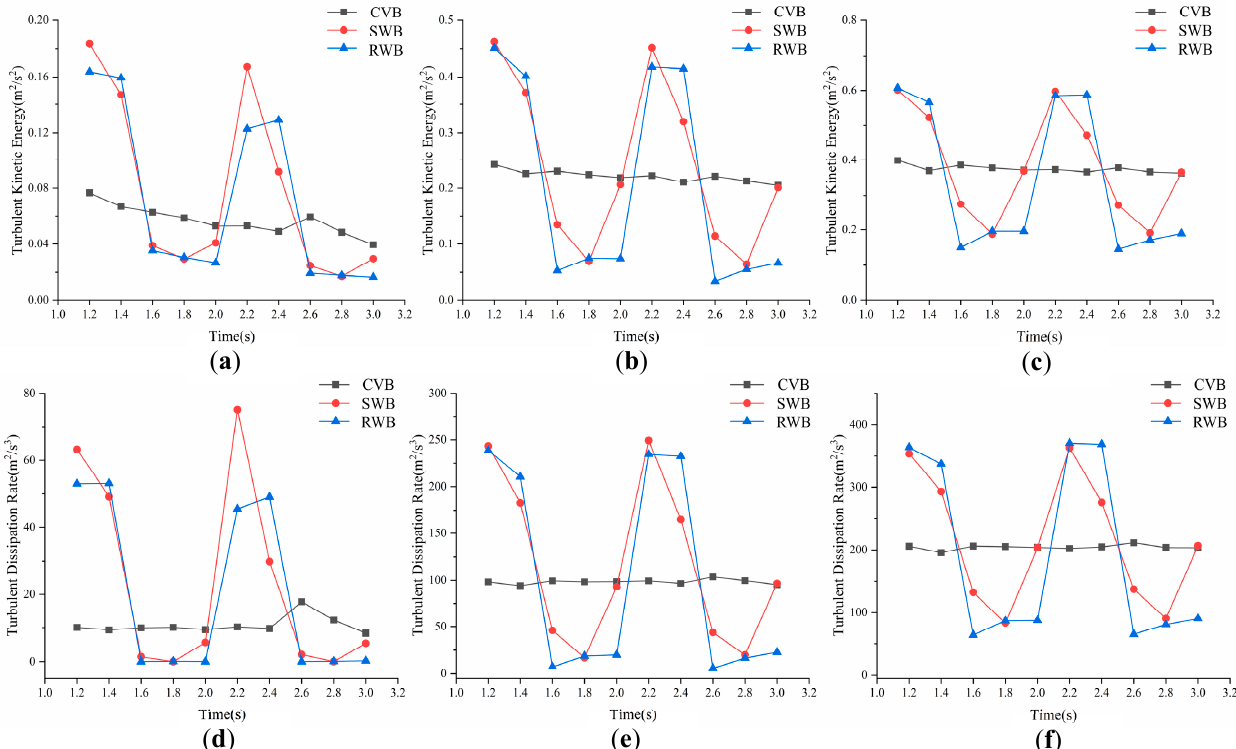
Figure 17. Turbulent kinetic energy performance on plane 2, plane 4, and plane 6: ( a ) Distribution of turbulent kinetic energy on plane 2; ( b ) Distribution of turbulent kinetic energy on plane 4; ( c ) Distribution of turbulent kinetic energy on plane 6; ( d ) Distribution of turbulent dissipation on plane 2; ( e ) Distribution of turbulent dissipation on plane 4; ( f ) Distribution of turbulent dissipation on plane 6.